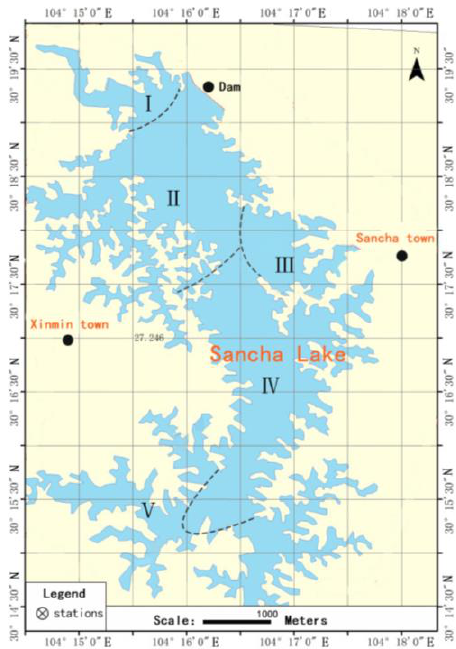
Figure 1. Sampling sites and function division in Sancha Lake.